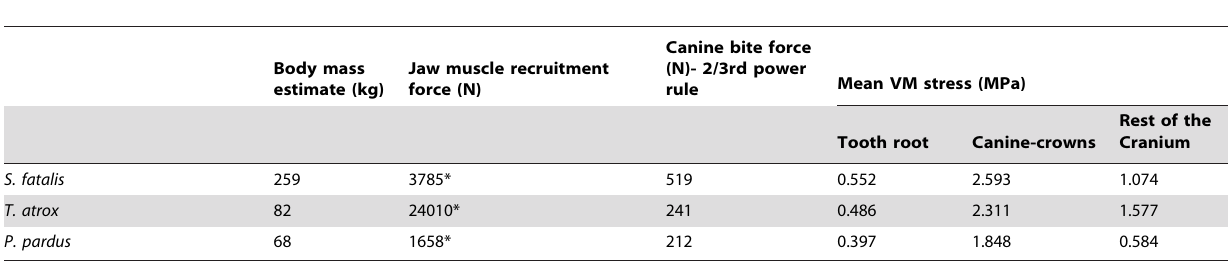
*Muscle forces were back-calculated from FE models that gave the body-mass-scaled bite-force output at canines assuming a 2/3 power relationship. The choice of reference taxon is immaterial in this context and S. fatalis was arbitrarily chosen here. kg=kilograms; N=Newtons.